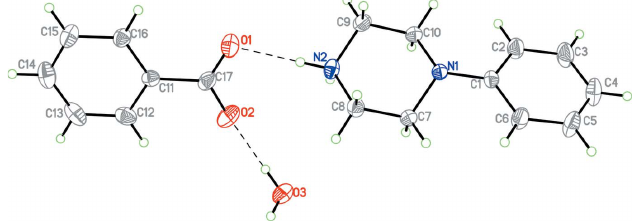
Figure 8 The molecular structure of 9 with hydrogen bonds shown as dashed lines. Atomic displacement parameters are at the 30% probability level.